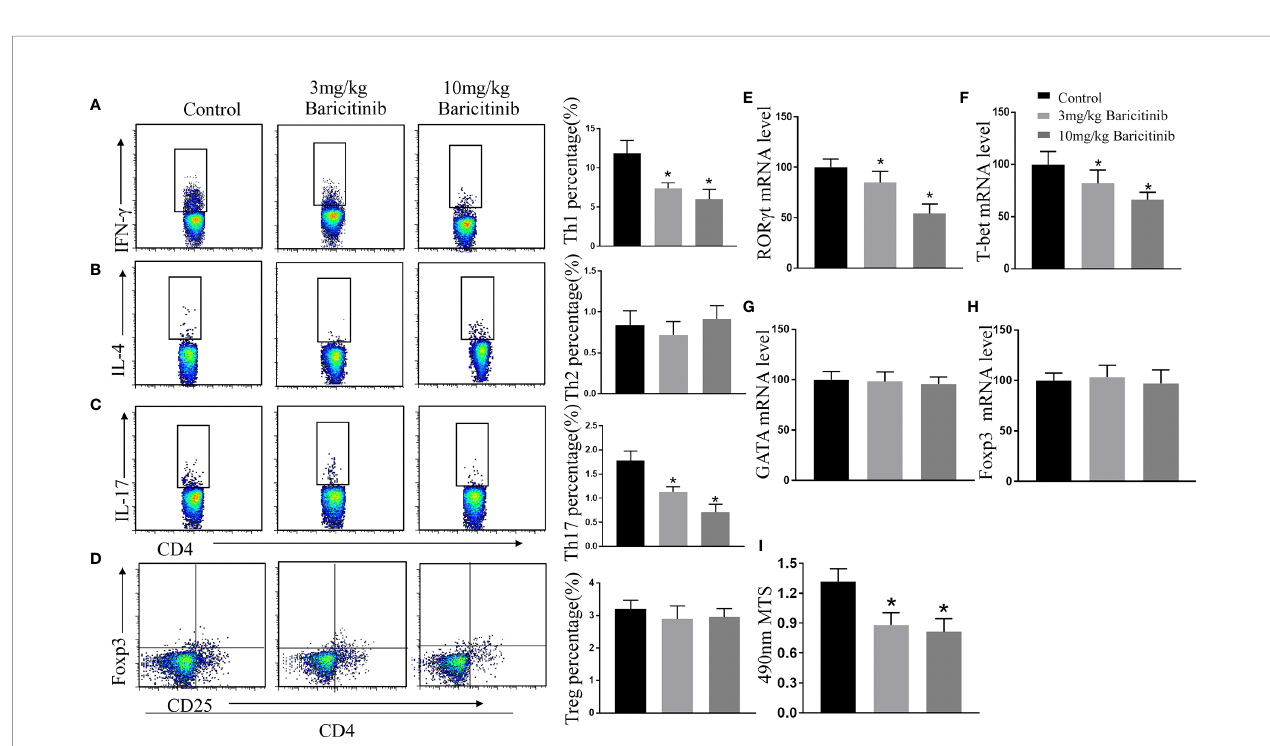
FIGURE 5 | Baricitinib treatment has an immunoregulatory effect on the spleen of experimental autoimmune encephalomyelitis (EAE) mice. Splenic mononuclear cells (MNCs) were isolated for fl ow cytometry to analyze the percentage of CD4+IFN- g + Th1 (A) , CD4+IL-4+ Th2 (B) , CD4+IL-17+ Th17 (C) , and CD4+CD25+Foxp3+ Treg cells (D) at the peak phase of EAE. The percentages of Th1 and Th17 cells in the splenic MNCs were decreased in baricitinib-treated mice compared with those in vehicle-treated mice. However, baricitinib did not affect the differentiation of CD4+IL-4+ Th2 cells and CD4+CD25+Foxp3+ Treg cells. (E – H) Quanti fi cation of the mRNA expression of T-bet, GATA, ROR g t, and Foxp3 in the baricitinib-treated groups and the control group. (I) MTS proliferation assays were performed to investigate the level of splenic lymphocyte proliferation. The results are displayed as the stimulation index. Baricitinib-treated groups exhibited signi fi cant reductions in proliferation. Quantitative data are the mean ± SEM. * p < 0.05; n = 6 per group. SEM, standard error of the